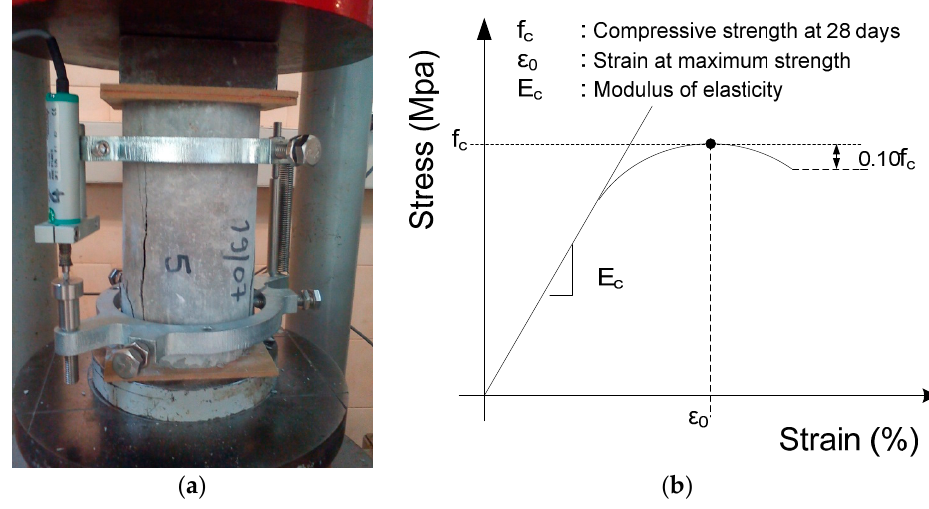
Figure 3. ( a ) Uniaxial compression test setup of sandcrete specimen; ( b ) Stress-strain curves.